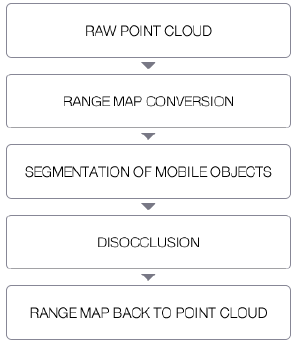
Figure 2. Overview of the proposed